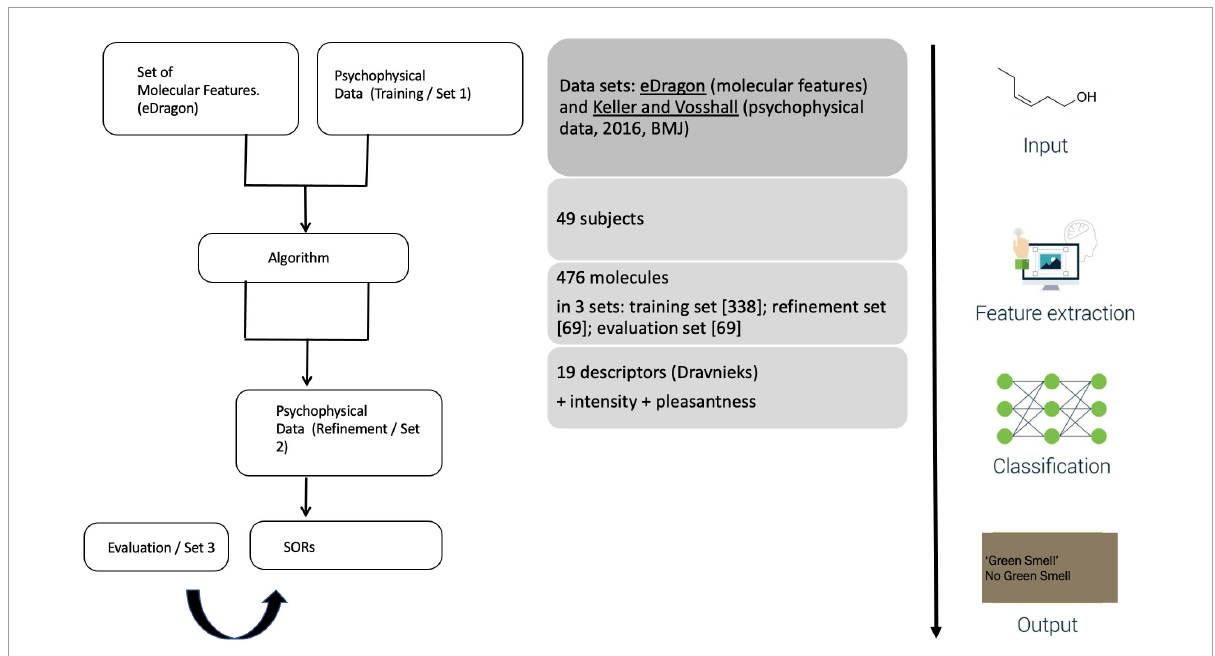
FIGURE3 Keller et al.’s (2017) experimental